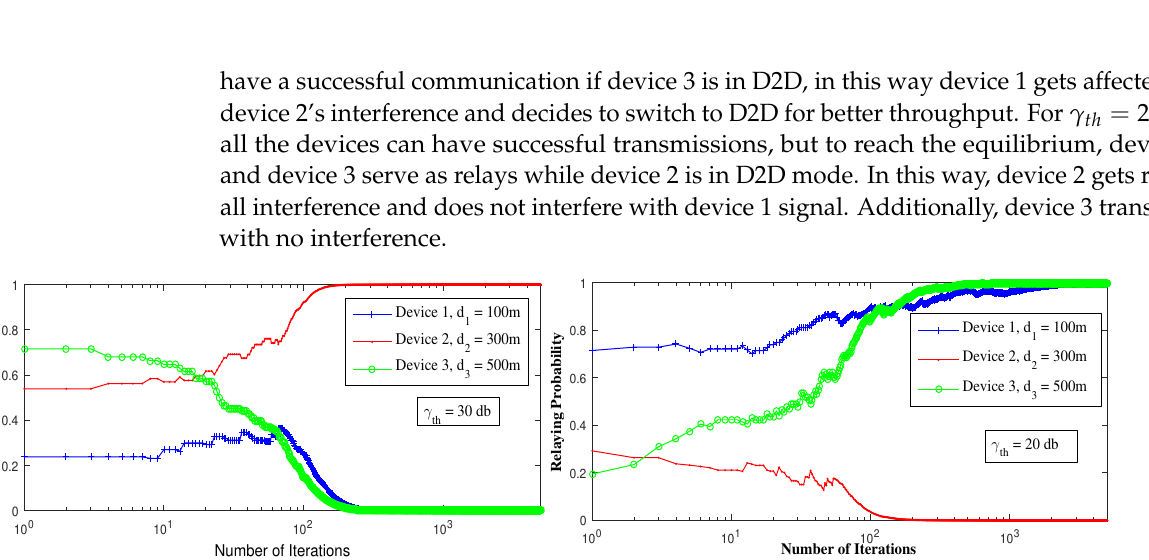
Figure 4. Convergence to pure Nash equilibrium using LRI, for different SINR threshold values ( γ th ).